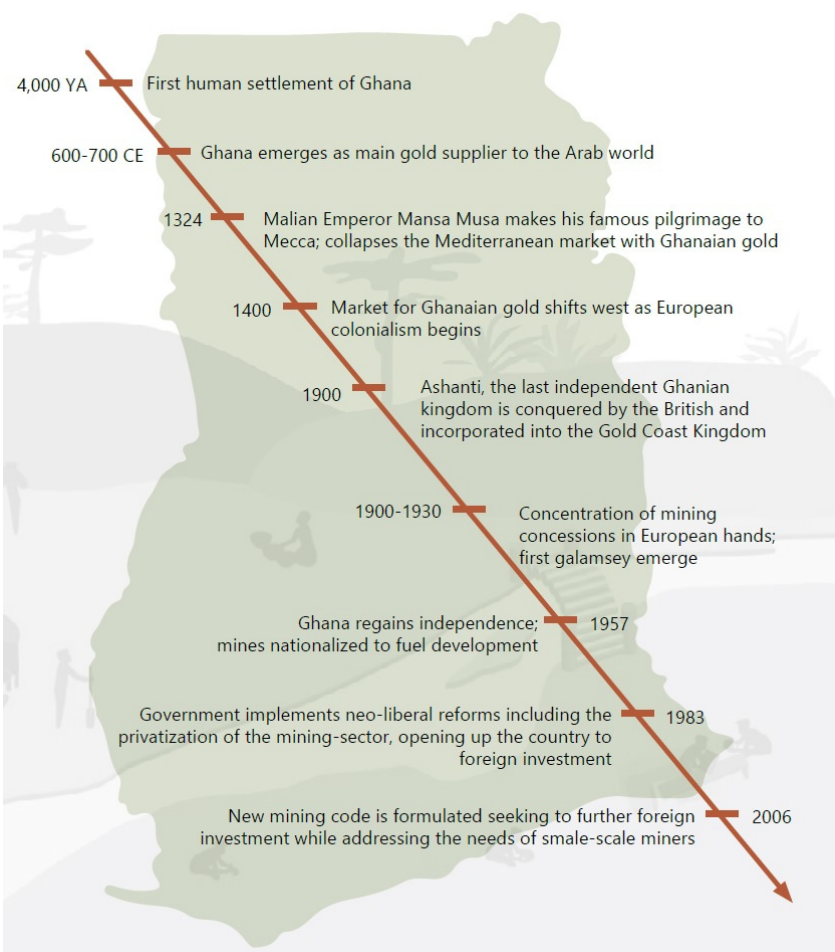
Figure 4. Timeline of Ghanaian mining